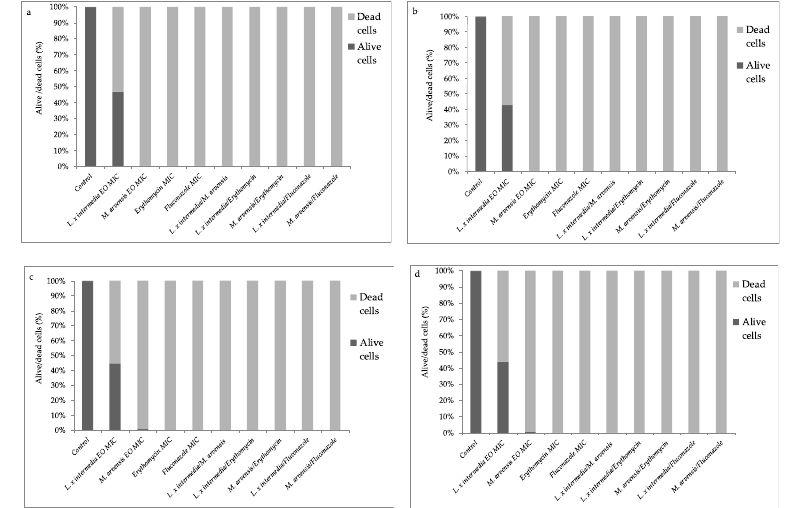
Figure 6. Quantification of alive / dead cells in the biofilm. Relative fluorescence units (RFU) mean of alive and dead cells into Lactobacillus spp. 1, Lactobacillus spp. 2, Lactobacillus spp. 3, and Lactobacillus spp. 4 (( a – d ), respectively) biofilm, treated with L. x intermedia and M. arvensis EOs, antimicrobials (erythromycin and fluconazole) and with di ff erent combinations (antimicrobial / EO and EO / EO). The data shown are representative of three determinations. Statistically significant di ff erence between alive and dead cells ( p -values < 0.05) was detected by Qui-square